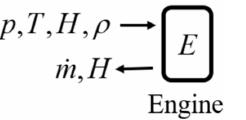
Figure 10. Interface parameters of engine.